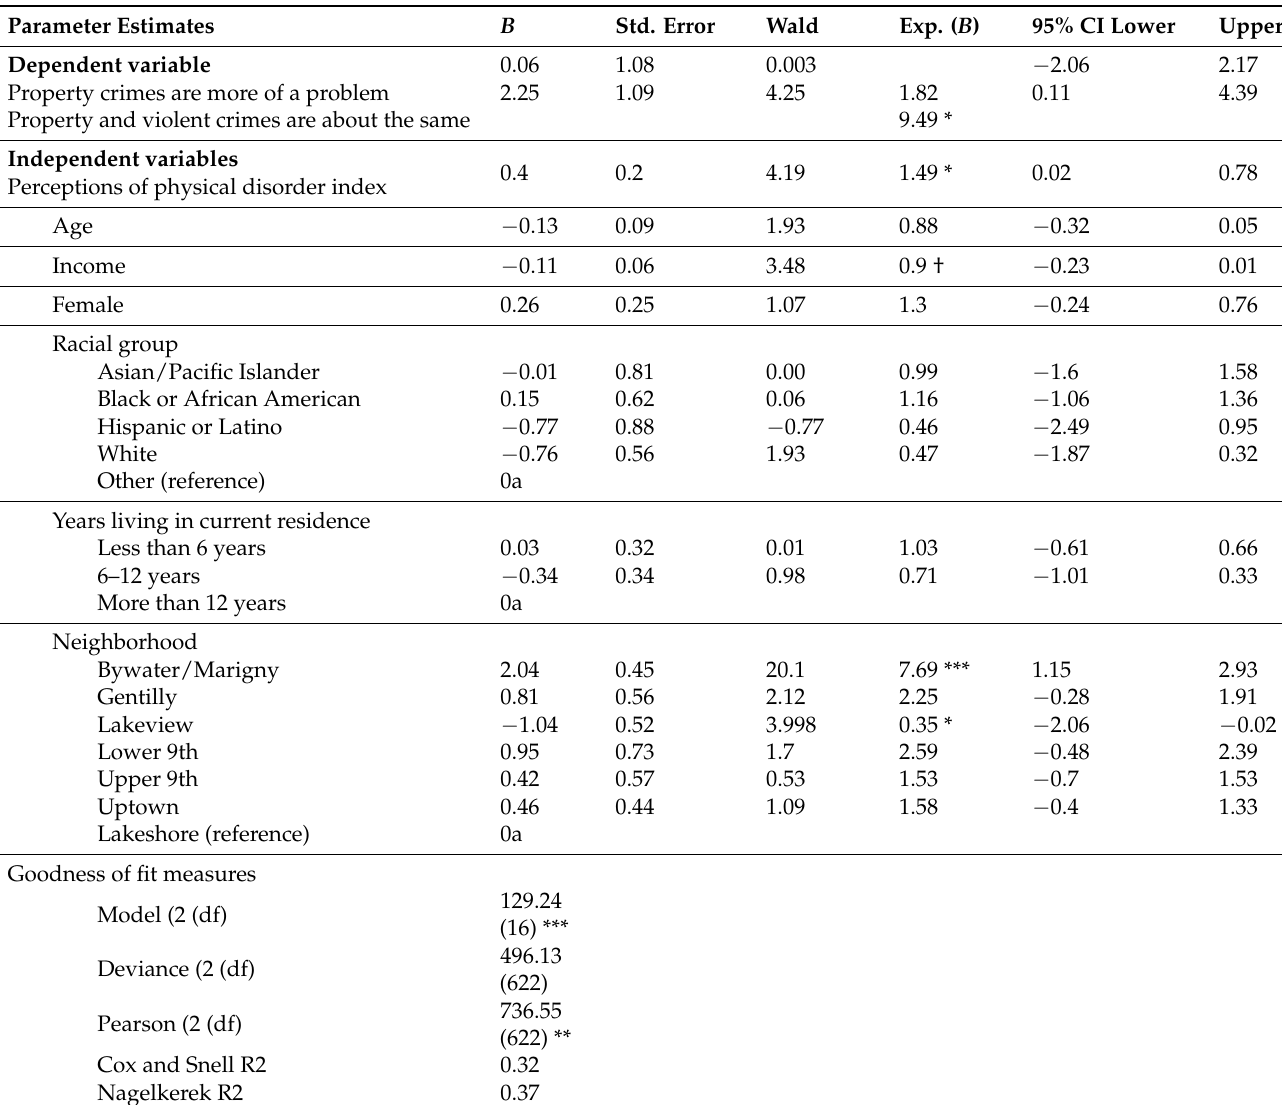
Table 2. Parameter Estimates of Ordinal Logistic Regression Model Predicting Socio-Demographic Characteristics, and Neighborhood on Residents’ Perceptions of Crime